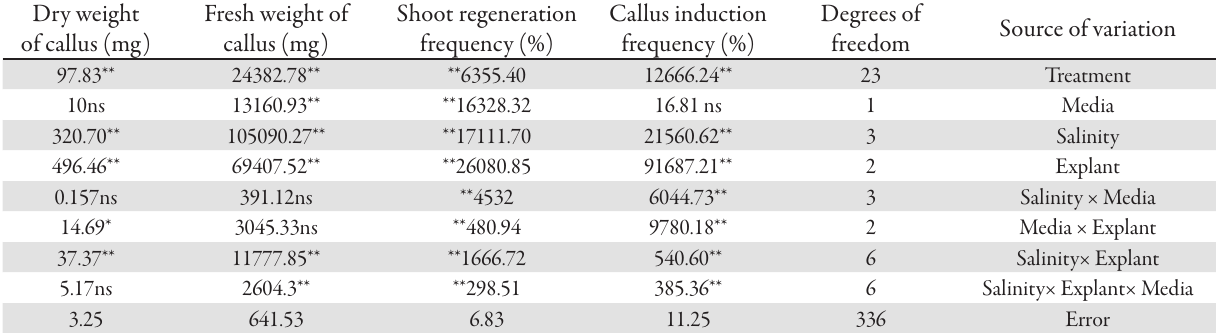
Tab. 4. Analysis of variance for studied traits of Foeniculum vulgare under salinity stress Dry weight